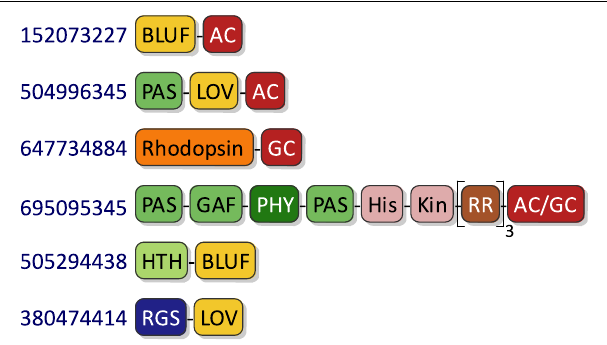
FIGURE 6 | Natural photoreceptors as optogenetic tools. Certain naturally occurring photoreceptors can serve as powerful light-regulated actuators in optogenetics without any need for re-engineering. The diagram shows domain architectures of select sensory photoreceptors that have been deployed for optogenetics or that could be used to that effect; exemplary Genbank accession numbers are provided that possess certain architectures. Abbreviations as in main text and as follows: AC, adenylate cyclase; GC, guanlyate cyclase; HTH, helix-turn-helix; RGS, regulator of G-protein signaling; RR, response